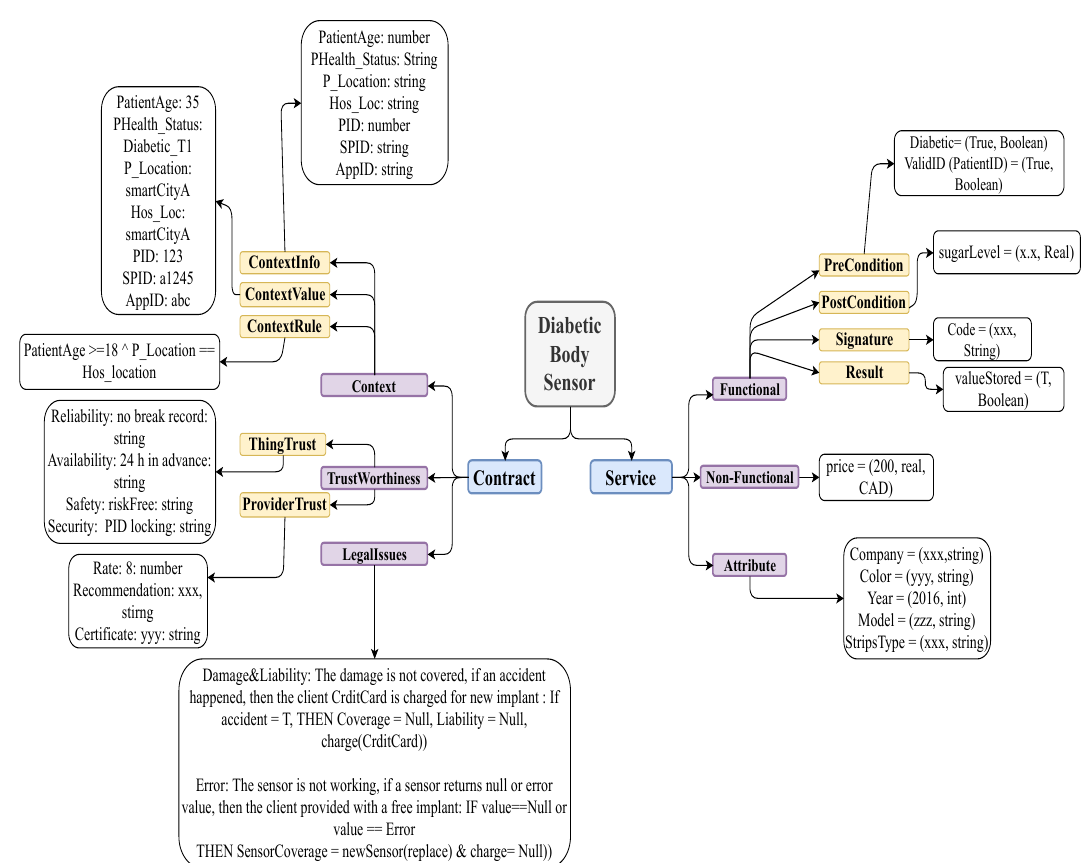
Figure 3. The Thing Implementation Structure